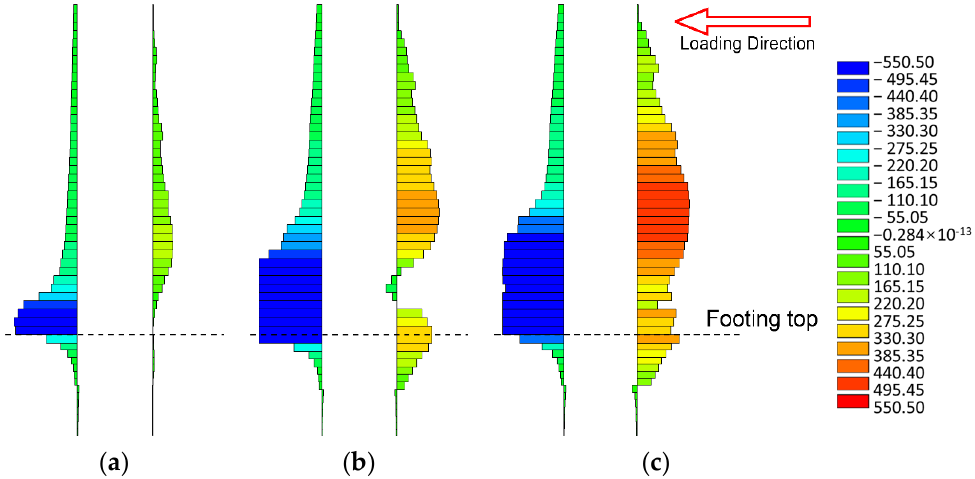
Figure 9. Rebar stress diagrams at each final state of (unit: MPa): ( a ) TPM (120 mm); ( b ) PMR (160 mm); ( c ) CIPM (160 mm).